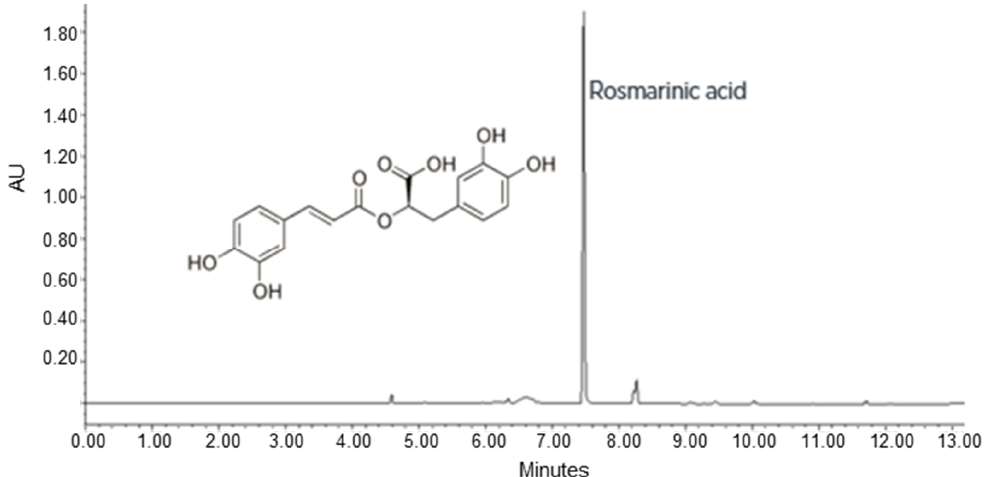
Figure 2. Representative UPLC chromatogram of Perilla frutescens (L.) Britton extract recorded at 330 nm. RA, which elutes at 7.5 min, represents the main component. RA—rosmarinic acid.